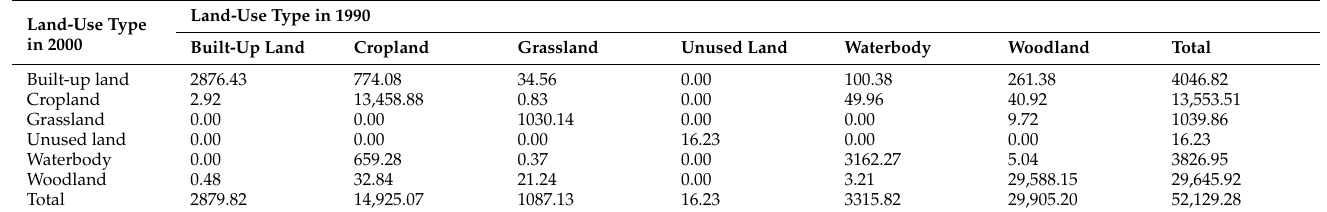
Figure 3. Land use change in the PRD region. Table 2. Land-use transitions in the PRD between 1990 and 2000 (km 2 ).